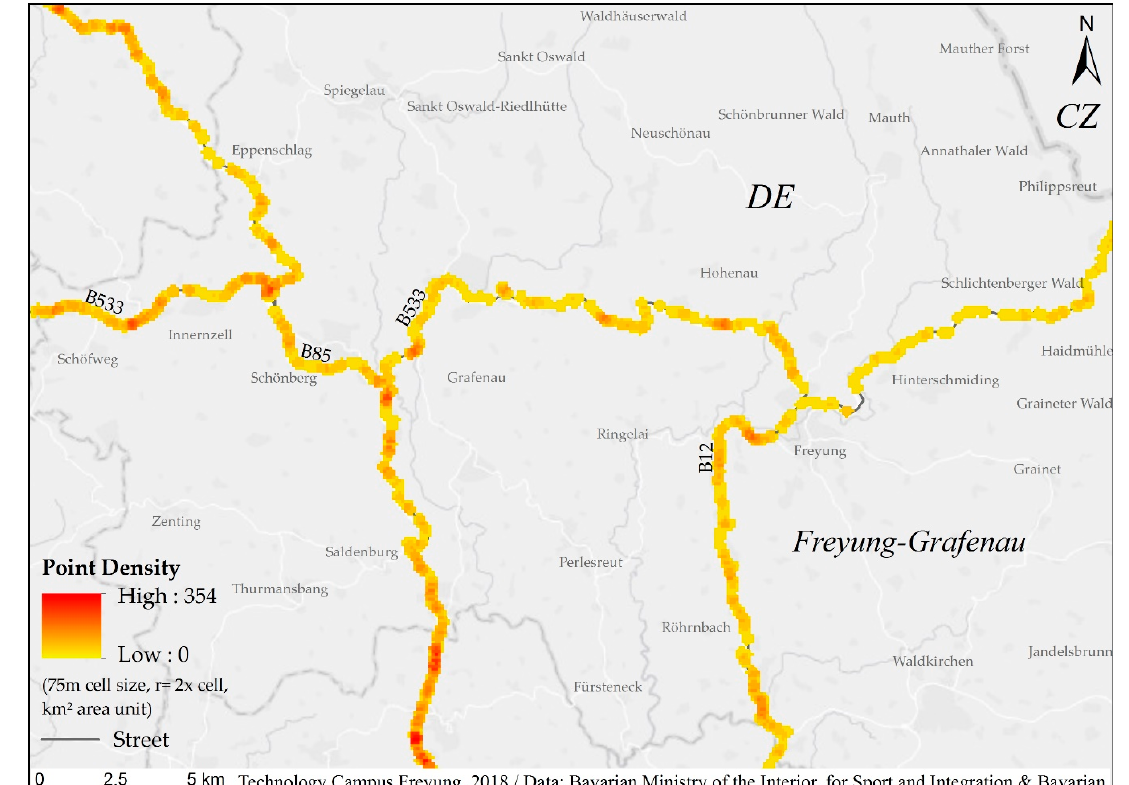
Figure 1. Wildlife–vehicle collision (WVC) density map of the research area. ISPRS Int. J. Geo-Inf. 2018 , 7 , x FOR PEER REVIEW